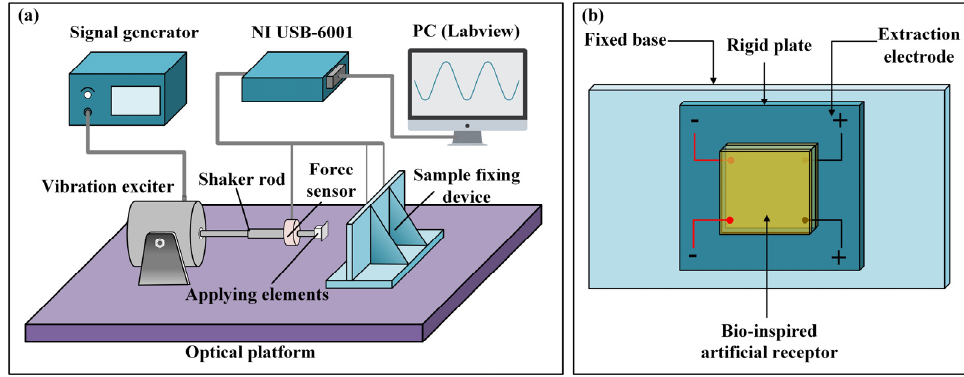
Figure 3. Schematic diagram of test platform for bio-inspired artificial receptor. ( a ) Integral test system. ( b ) The sample fixing device.